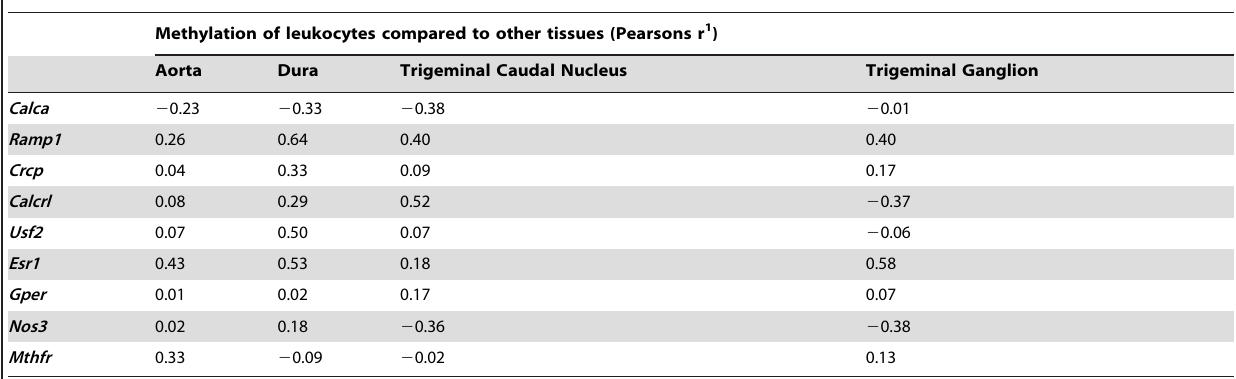
Table 3. Relationship of methylation of leukocytes with other